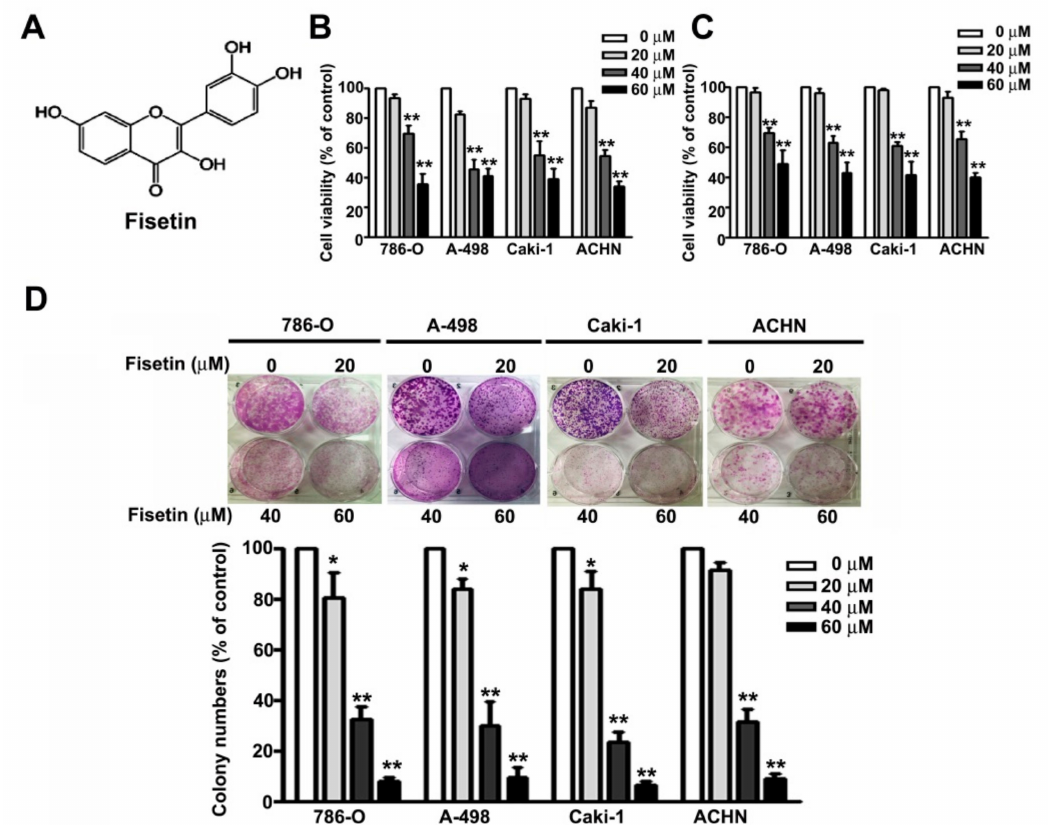
Figure 1. Fisetin inhibits the cell proliferation and colony formation ability of renal cell carcinoma (RCC) cell lines. ( A ) The chemical structures of fisetin. 786-O, A-498, Caki-1, and ACHN cells incubated with various concentrations (0, 20, 40, and 60 µ M) of fisetin for 24 h. Cell viability was determined through the ( B ) 3-(4,5-cimethylthiazol-2-yl)-2,5-diphenyl tetrazolium bromide (MTT) assay and ( C ) CCK8 assay. ( D ) RCC cells were then harvested to determine the number of colonies after treatment with